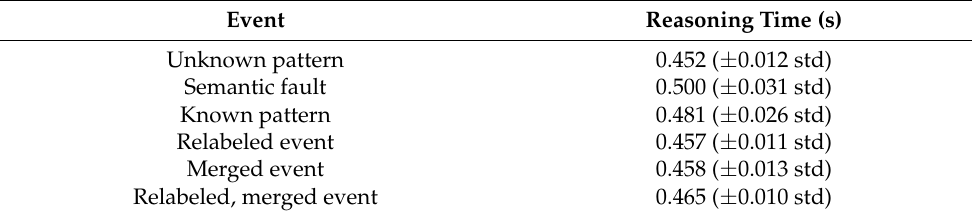
Table 1. Execution times, in seconds, required for the visualization reasoning of all types of